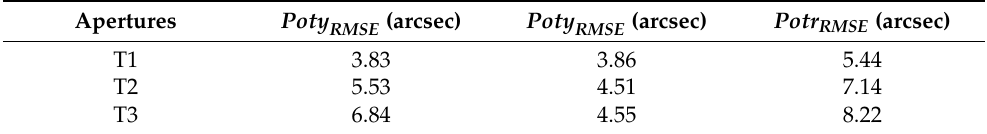
Figure 4. Position of the target in polar coordinate system, from right to left, named P1, P2, . . . , P14 respectively. Table 2. RMSE of pointing of each sub-aperture.